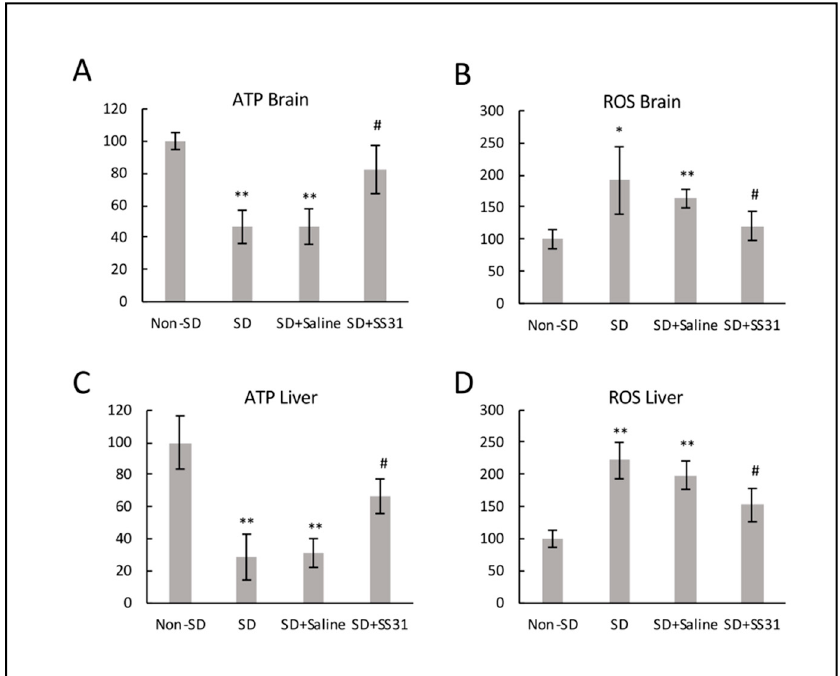
Figure 2. Mitochondria from brain and liver of sleep-deprived mice treated with SS31 had restored ATP and decreased reactive oxygen species (ROS). ROS and ATP levels were measured using isolated mitochondria from brain and liver. The y -axis shows percentages, with the non-SD group being 100 percent. ( A ) ATP level in brain tissue, ( B ) ROS level in brain tissue, ( C ) ATP level in the liver tissue, and ( D ) ROS level in liver tissue. All data represent the mean ± SEM of three independent triplicate experiments. ** p < 0.01, * p < 0.05, statistically significant difference between SD group/SD + Saline group and Non-SD group. # p < 0.05, statistically significant difference between SD+SS31 group and SD group/SD + Saline group.